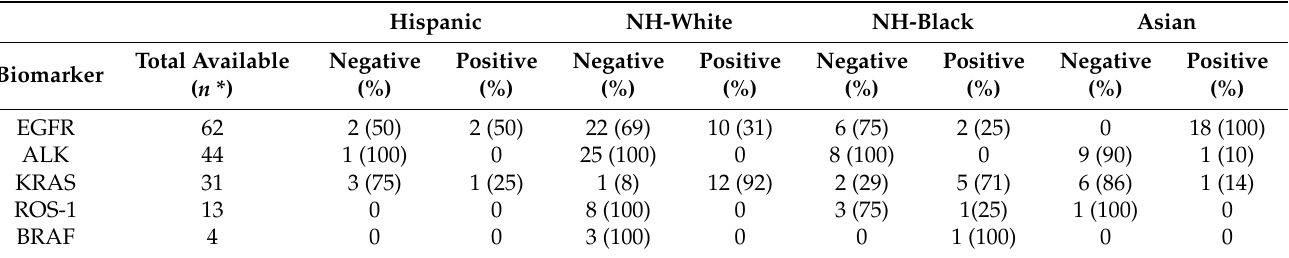
Table 4. Biomarker status of women lung adenocarcinomas in the WTC Environmental Health Center separated by race and